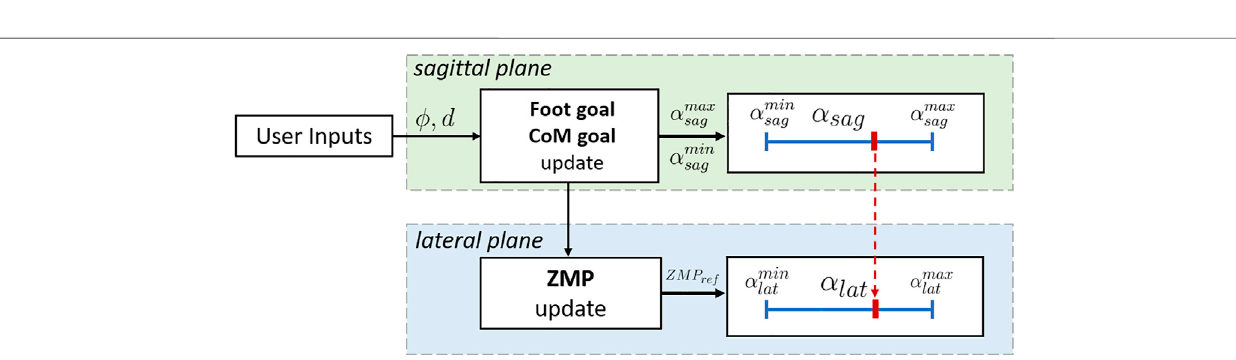
FIGURE 4 | Detail of the synchronization process between lateral and sagittal plane. The commands θ and d , when received, update the foot and the CoM goal in thesagittaldirection, whichinturnsmodify theextremaofthephase variable, α max sag and α min sag .TheZMP isupdatedaccordingly,and usedinthepreviewwindow fedtothe PC. The lateral phase variable α lat is synchronized with the evolution of α sag